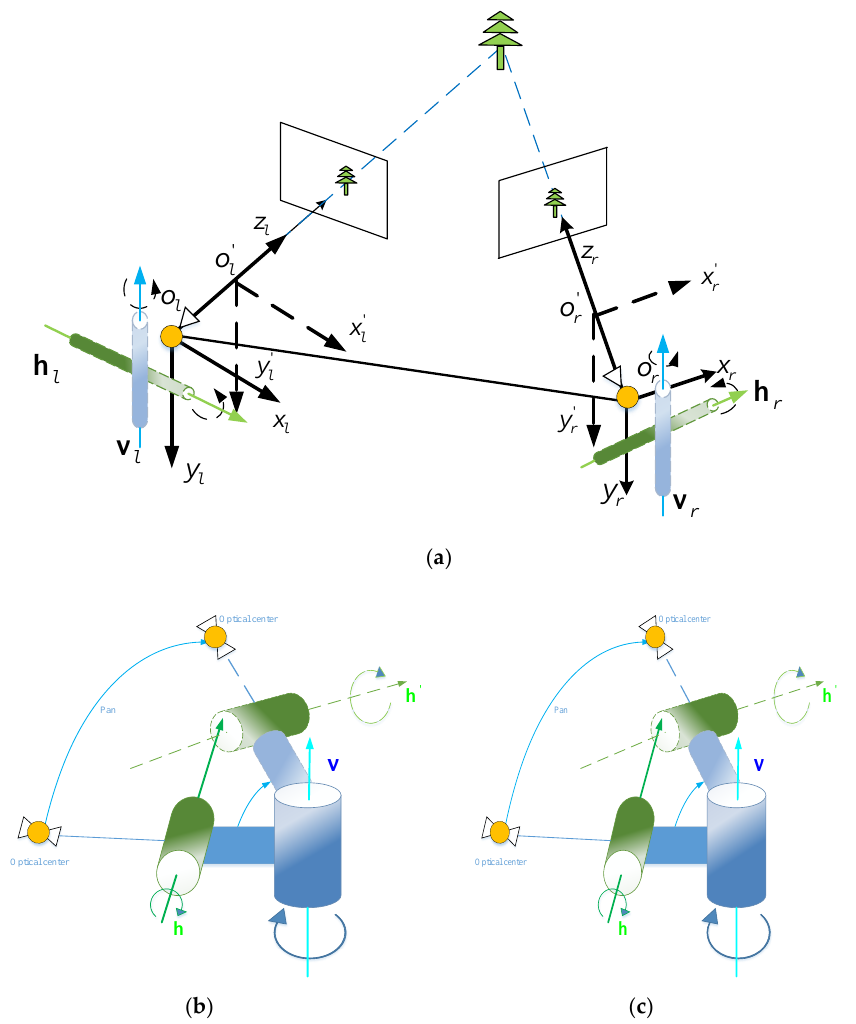
Figure 1. ( a ) General model for dual-PTZ cameras. ( b ) The pitching rotation axis is the driven axis. ( c ) The horizontal rotation axis is the driven axis.